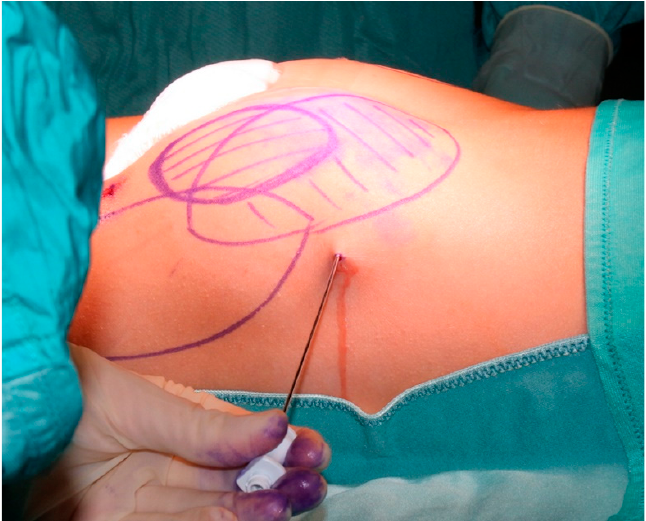
Figure 1. Harvesting of fat tissue in very thin patients (buttocks and supragluteal area).